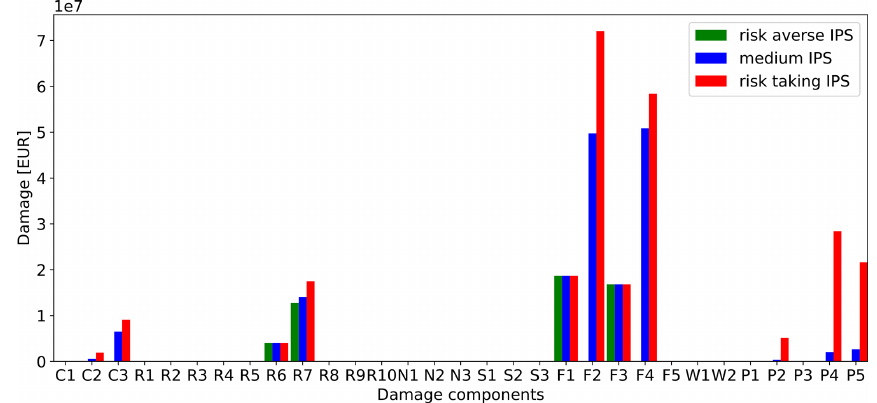
Figure 8. Damage components and damage estimation for all structures for